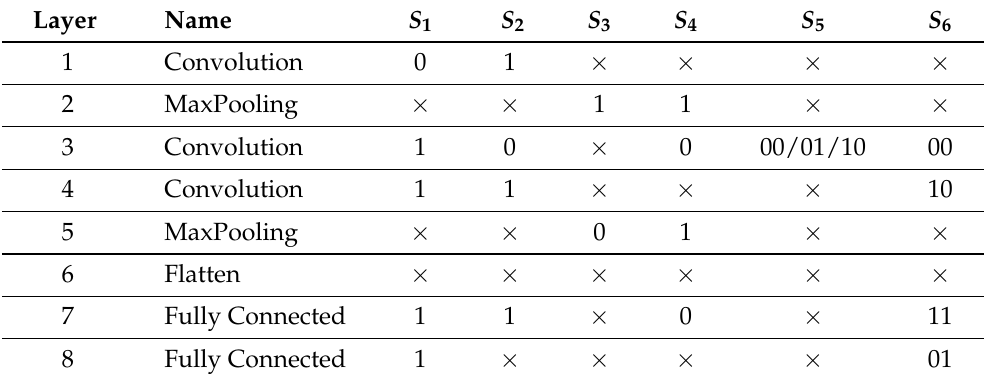
Table 3. The designated values of the select input(s) of each multiplexer when operating at different layers.